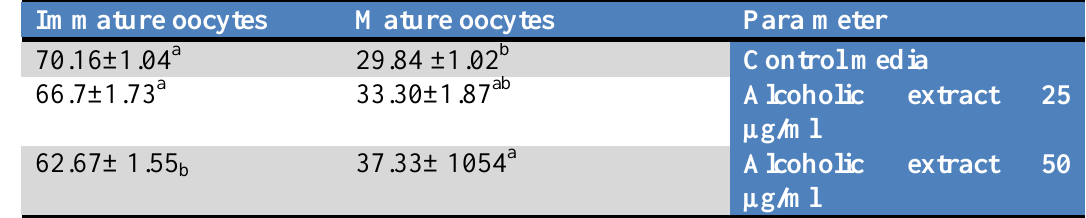
Table 3 the effect of alcoholic extract of tribulus terrestris on the maturation percentage of small follicles (1-5mm).(M±S.D)